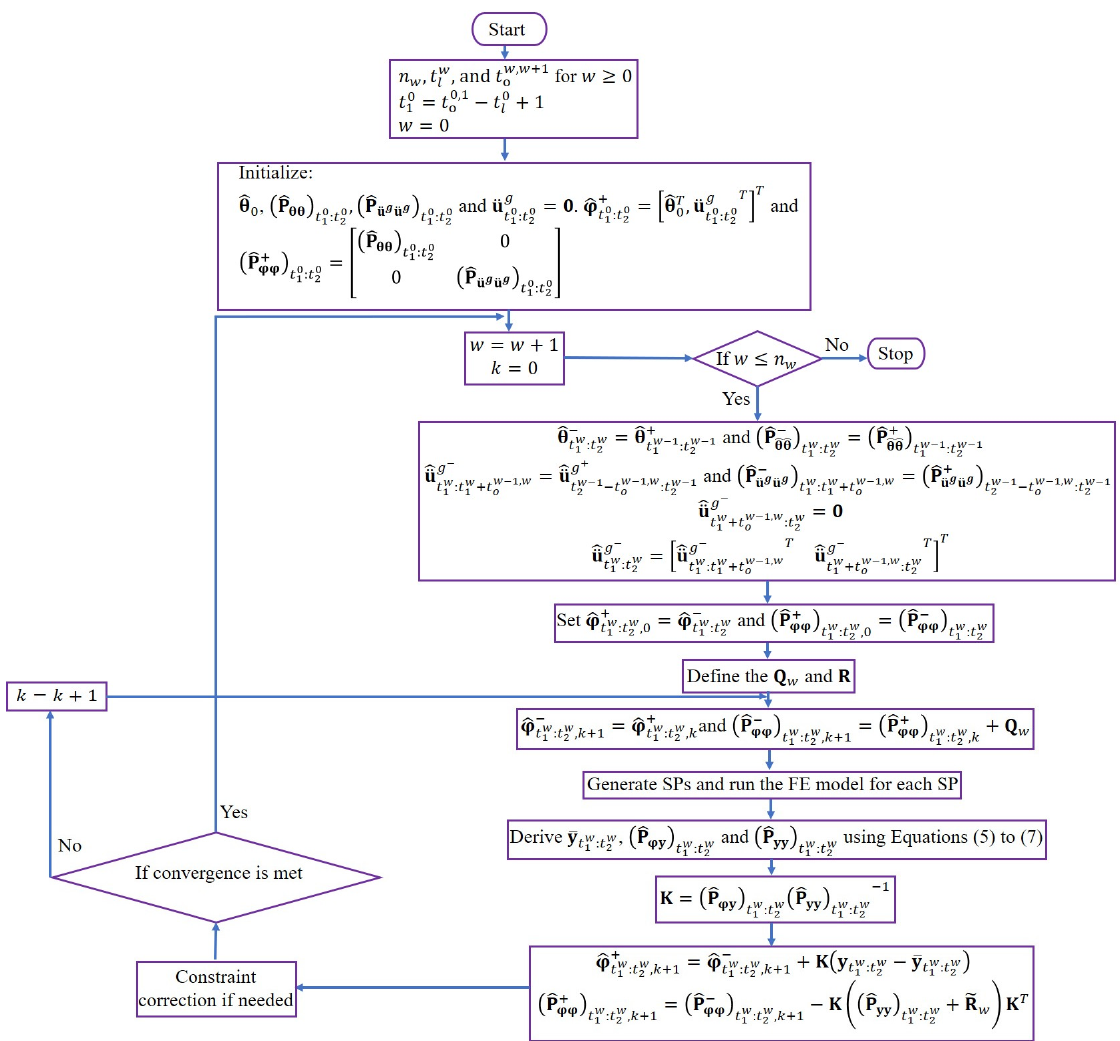
Figure 3. Sequential Bayesian FE model updating flowchart based on the UT method for joint esti- mation of the unknown model parameters and the FIM time histories.